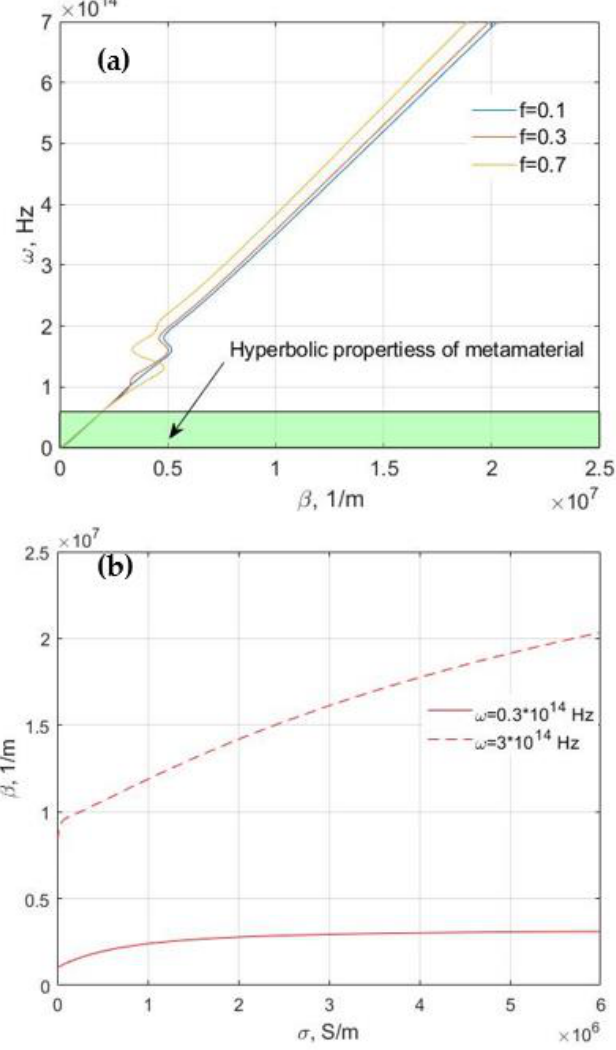
Figure 6. Solution of the dispersion equation versus frequency ( a ) and versus conductivity ( b ). ε n = 11.8, ε d = 2.25. Herein ITO inclusions are employed in nanocomposite and hypercrystal, f = 0.3 in ( b ).